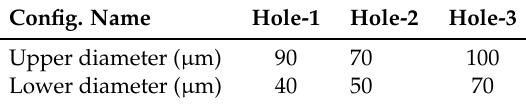
Table 1. Studied hole configurations.